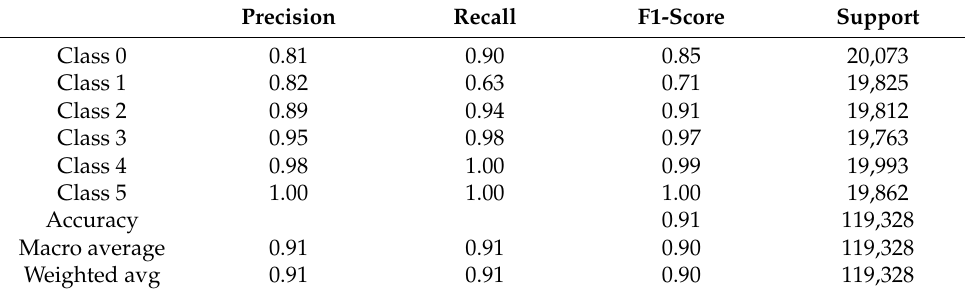
Table 3. Performance of six categories on each metric. Precision Recall F1-Score